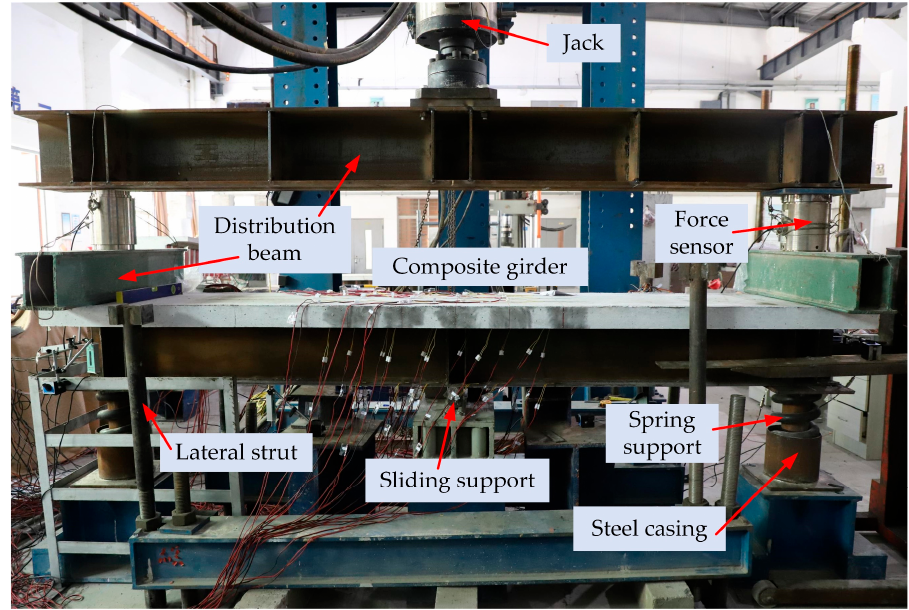
Figure 3. Loading scheme.